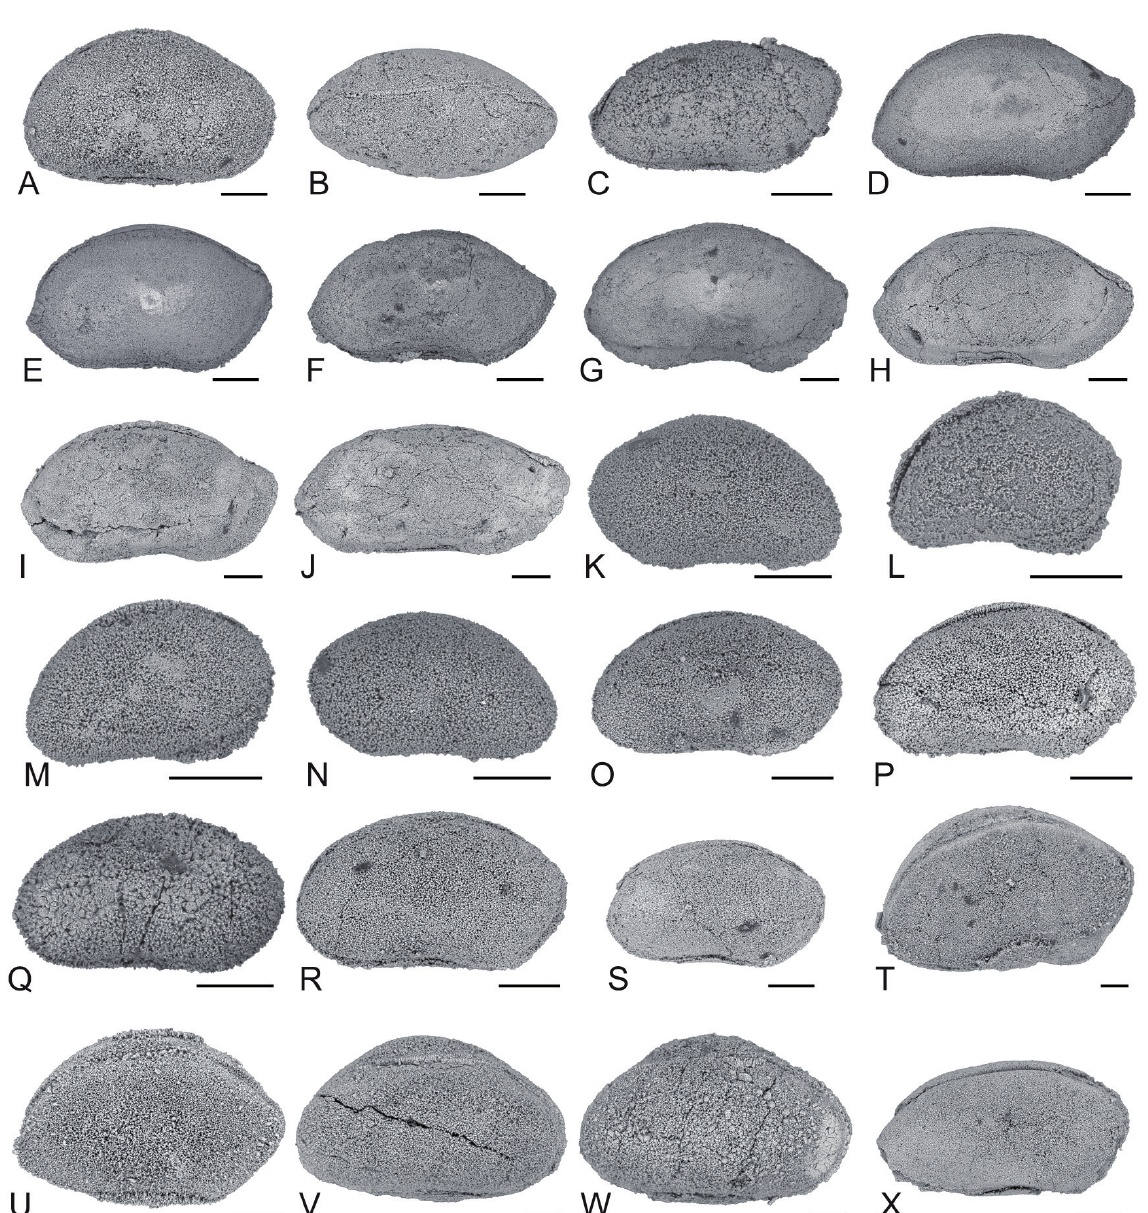
Fig. 7. Ostracods from the Dajiang section, South China. — A–B . Bairdia sp. 3. A . Carapace, right lateral view, P6M2963. B . Carapace, dorsal view, P6M2964. — C . Bairdia sp. 4, Carapace, right lateral view, P6M2965. — D–J . Bairdia sp. 5. D . Carapace, right lateral view, P6M2966. E . Carapace, right lateral view, P6M2967. F . Carapace, right lateral view, P6M2968. G . Carapace, right lateral view, P6M2969. H . Carapace, right lateral view, P6M2970. I . Carapace, right lateral view, P6M2971. J . Carapace, right lateral view, P6M2972. — K–M . Bairdia ? sp. 6. K . Carapace, left lateral view, P6M2973. L . Carapace, right lateral view, P6M2974. L . Carapace, right lateral view, P6M2975. — N–S . Bairdia sp. 7. N . Carapace, left lateral view, P6M2976. O . Carapace, right lateral view, P6M2977. P . Carapace, right lateral view, P6M2978. Q . Carapace, right lateral view, P6M2979. R . Carapace, right lateral view, P6M2980. S . Carapace, right lateral view, P6M2981. — T–U . Bairdia sp. 8. T . Carapace, right lateral view, P6M2982. U . Carapace, right lateral view, P6M2983. — V–W . ? Bairdia sp. 8. V . Carapace, right lateral view, P6M2984. W . Carapace, right lateral view, P6M2985. — X . Bairdia sp. 9, carapace, right lateral view, P6M2986. – Scale = 100